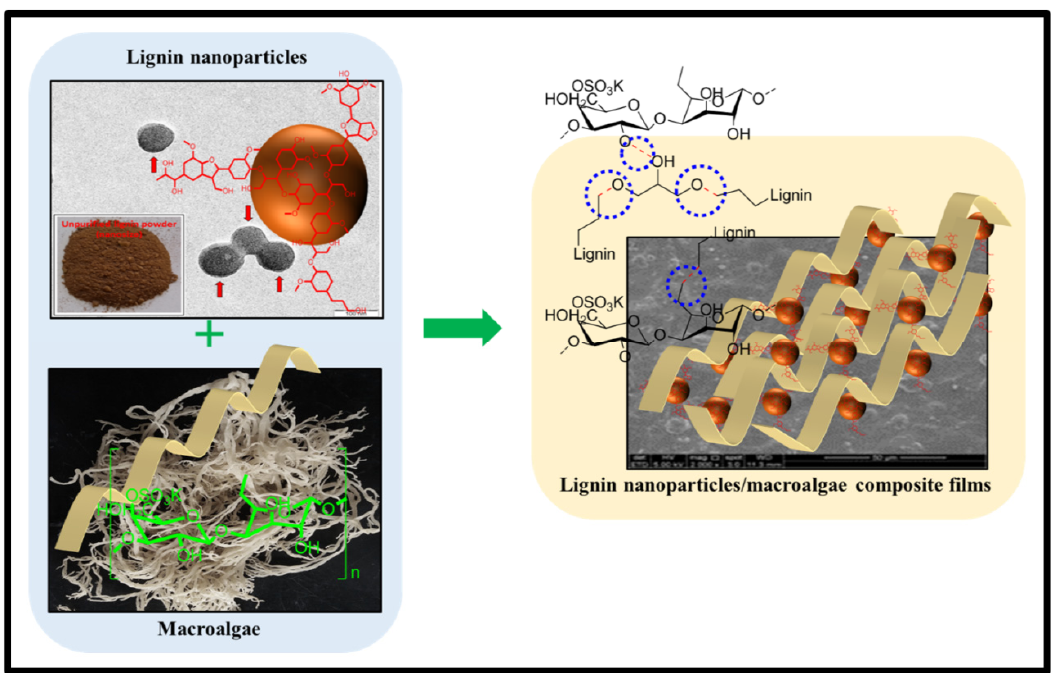
Figure 4. Schematic diagram of LNPs functioned in macroalgae matrix with a blue circle representation of the hydrogen bond.